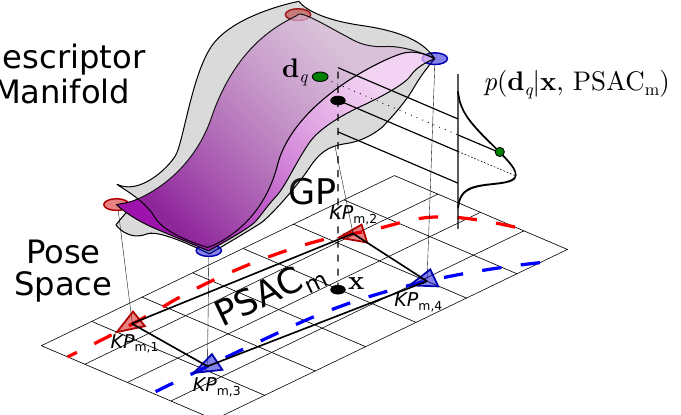
Figure 1. The Gaussian Process (GP) associated to a Patch of Smooth Appearance Change (PSACs) approximates the geometry of a neighborhood of the Descriptor Manifold (assumed to be locally smooth) with respect to the pose space, predicting the local likelihood p ( d q | x ,PSAC m ) of the ob- servation d q in a given pose x . In this example, the descriptor–pose pairs are extracted from two previous trajectories of the robot (in red and